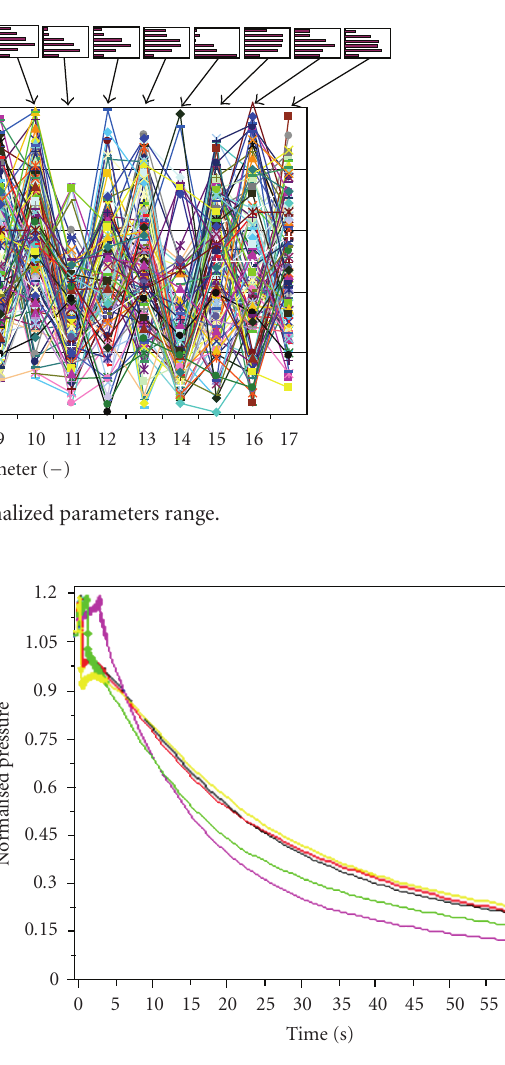
Figure 8: Pressure evolution—normalized scale—Long-term (a priori deterministic selected